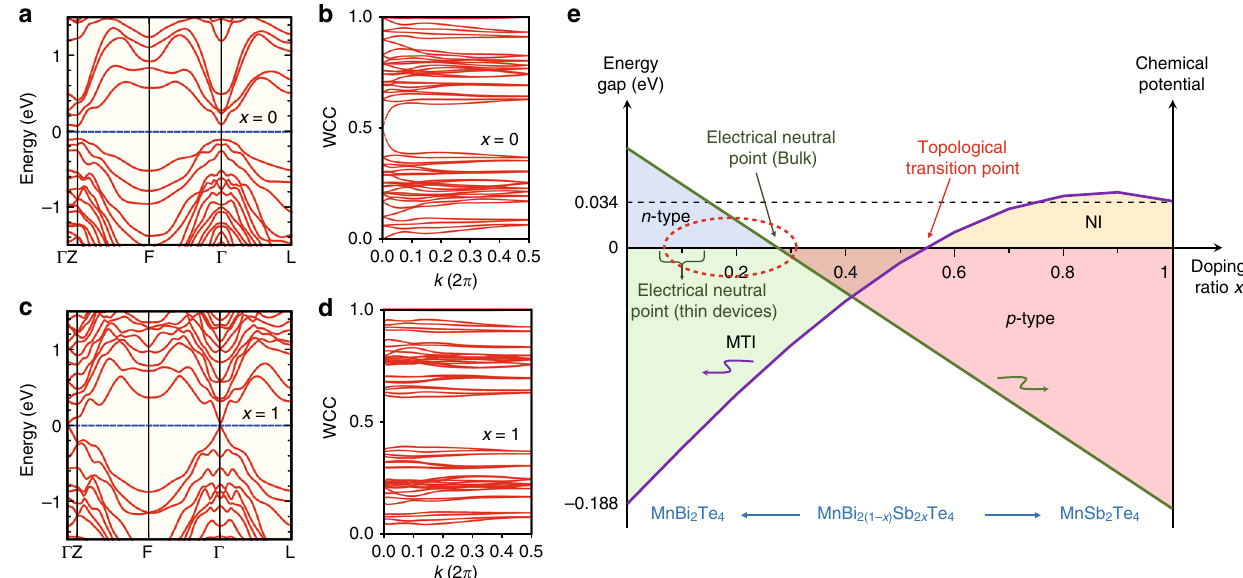
Fig. 5 Topological properties and the summary phase diagram. a , b Band structure and the evolution of Wannier charge centers (WCCs) of MnBi 2 Te 4 ( x = 0). c , d Band structure and evolution of WCCs of MnSb 2 Te 4 ( x = 1). e N – p carrier transition and topological phase transition diagram of Mn(Sb x Bi (1 − x ) ) 2 Te